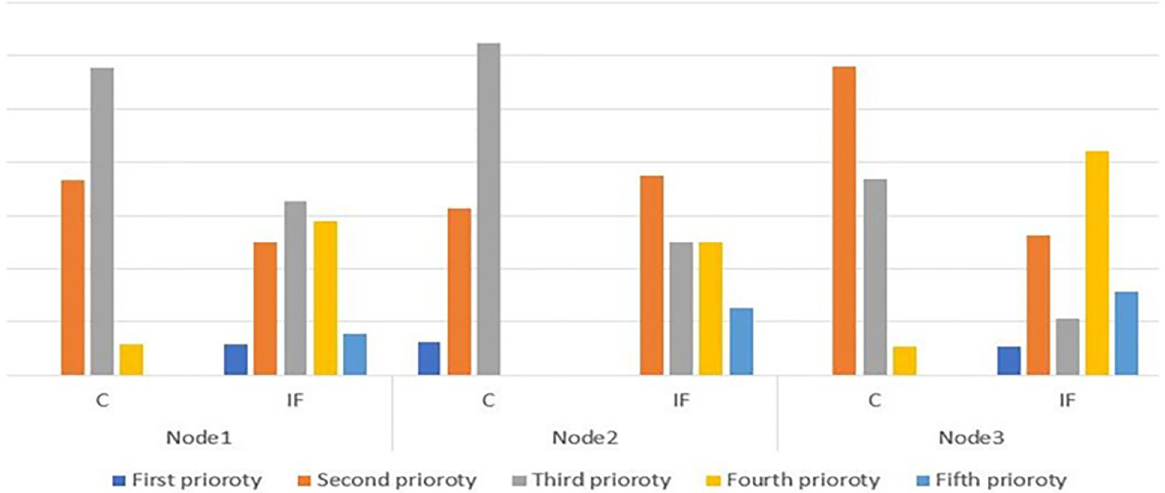
Fig 8. Relative abundance distribution of risk level of deviations detected in conventional (C) and fuzzy approach (IF).